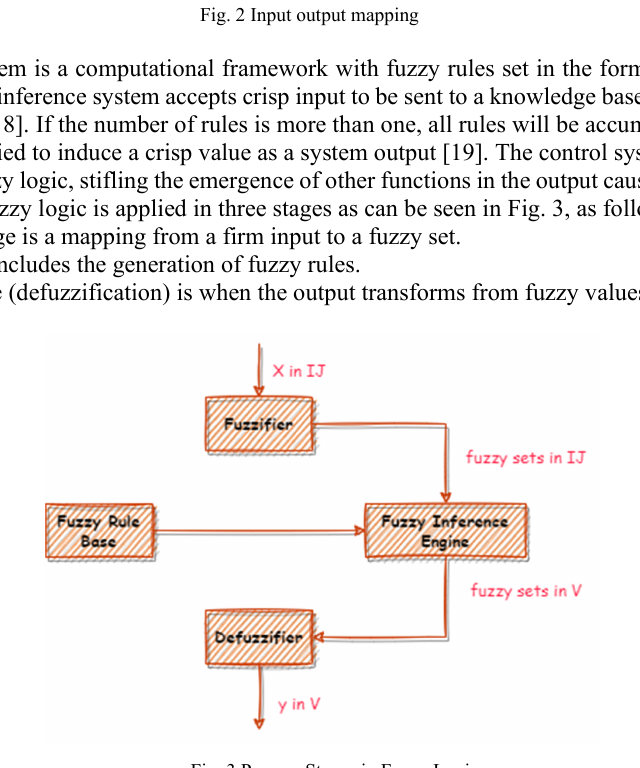
Fig. 3 Process Stages in Fuzzy